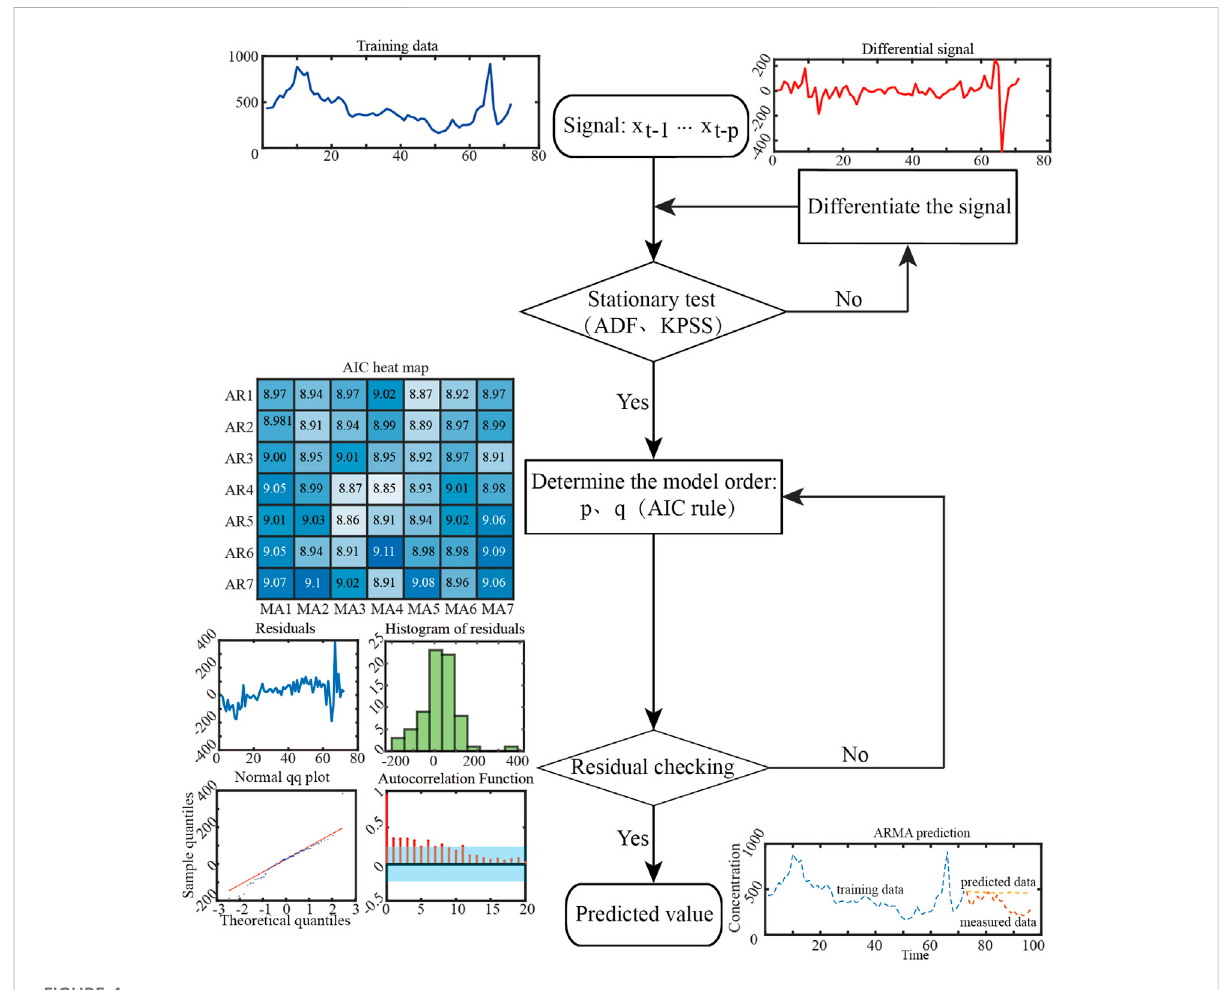
FIGURE 4 Flow chart of ARMA prediction